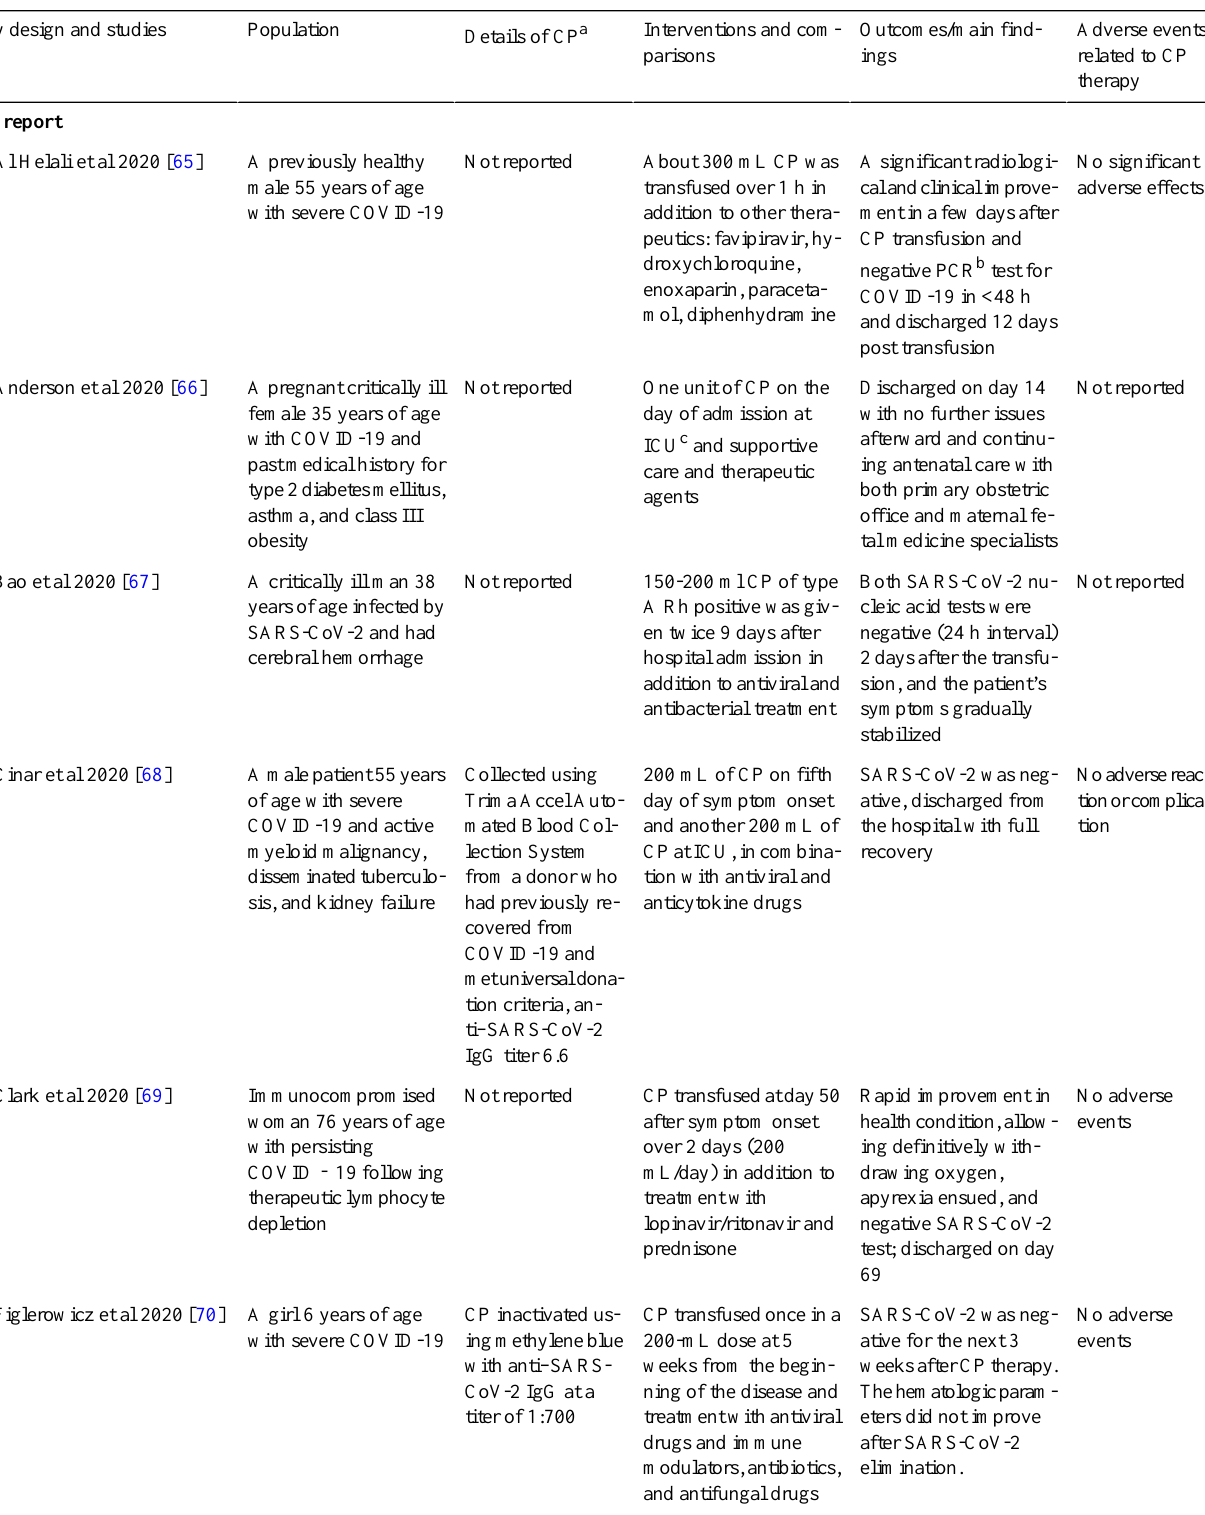
Table 2. Summary of original clinical studies of CP therapy for COVID-19. The studies were stratified according to the study